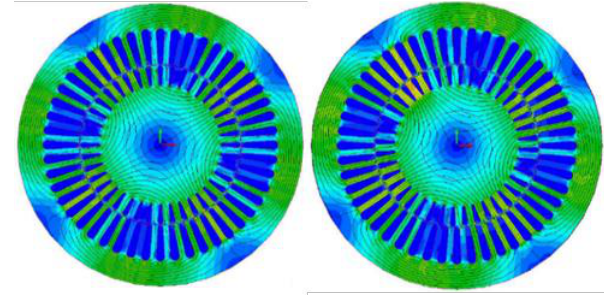
Fig. 3. Normalized magnetic field density of healthy and broken rotor bar motors.